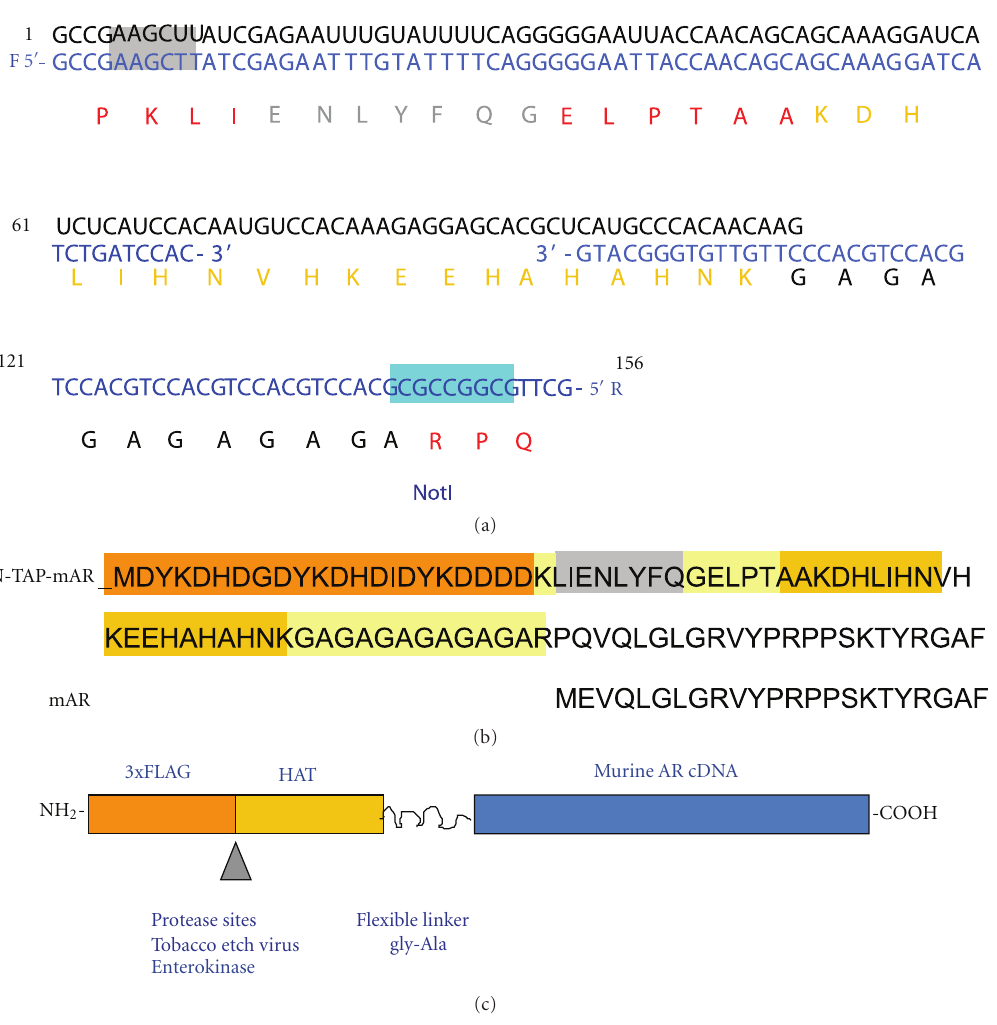
Figure 1: Creation of the mouse N-TAP-mAR. (a) Amplification of the TEV-HAT-glycine alanine repeat sequence with primers F and R using the C-TAP from Fern´andez et al., 2009 [9] as template. (b) Aminoacid sequence of the complete NH2-terminus of the androgen receptor. The N-TAP increases the size of the mAR by 70 amino acids and the molecular weight by 7.8kDa (http://web.expasy.org/compute pi/). (c) Schematic showing the tagged androgen receptor (N-TAP-mAR) cDNA clone. The N-terminal TAP tag was selected on the basis of small size. It contains three FLAG epitopes (3xFLAG) and 6xHistidine residues (HAT) located in an alpha